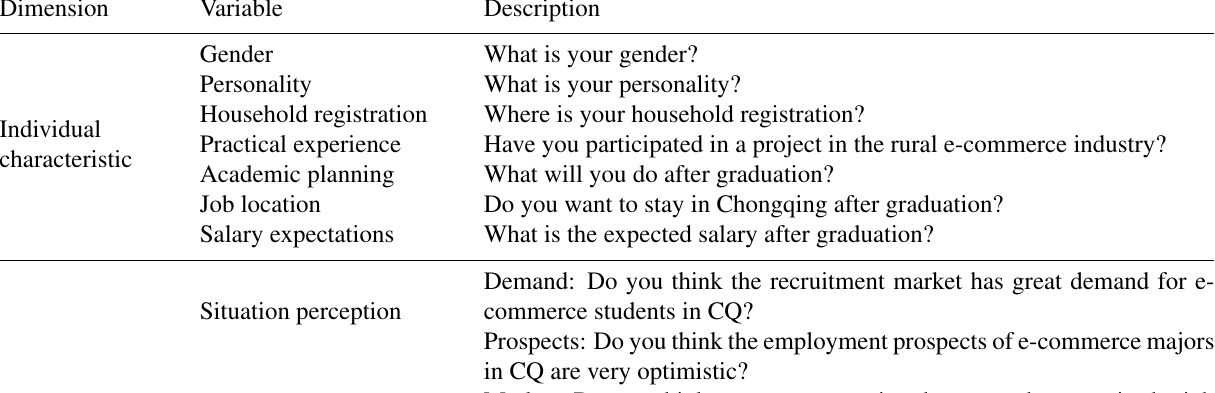
Table 1 Description of measurement